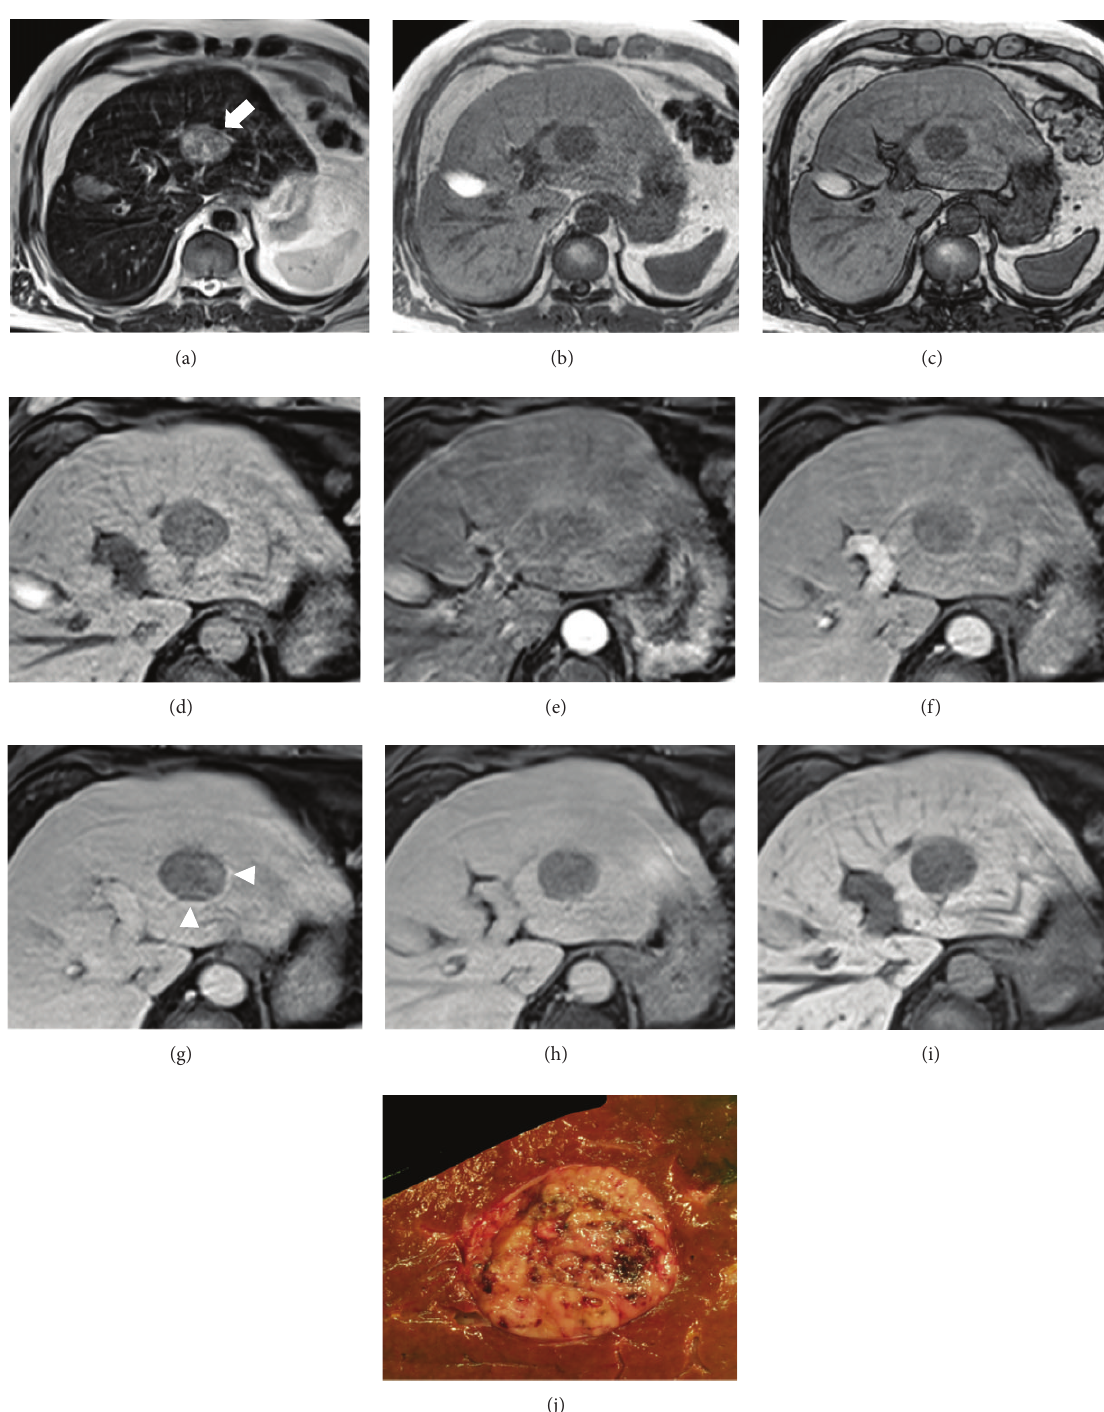
Figure9:HCCinnoncirrhoticliver.(a)AxialT2wimage.InSII-SIIIslightlyhyperintensewelldelineatedlesion(arrow).(b-c)InT1win-and out-phased images of the lesion appears hypointense. (d–h) In dynamic evaluation after Gd-EOB-DTPA administration the nodule appears slightly hypervascular in arterial phase (e); it shows rapid and progressive wash out in portal and equilibrium phases. Note the presence of a pseudocapsule (arrowhead) in equilibrium phase. (i) Hepatobiliary phase image after 20 󸀠 . The lesion appears hypointense. (j) Pathologic specimen confirms the presence of HCC nodule in normal